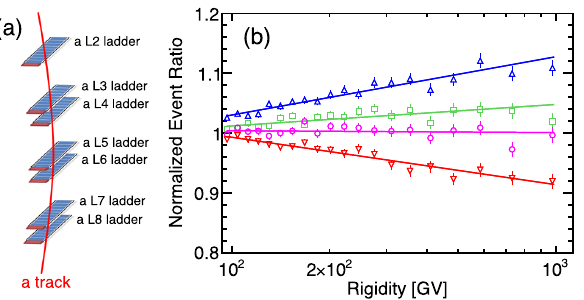
Fig. 21 a Schematic of a ladder combination of the inner tracker and b the slope fits (lines) to the normalized event ratios ( (cid:28) n i / (cid:28) n ) of 4 dif- ferent ladder combinations with each specified by a set of symbols (up triangles, squares, circles, or down triangles). The different rigidity dependences of the ratios, or the deviation among the slopes, induced by the different curvature biases, are clearly seen